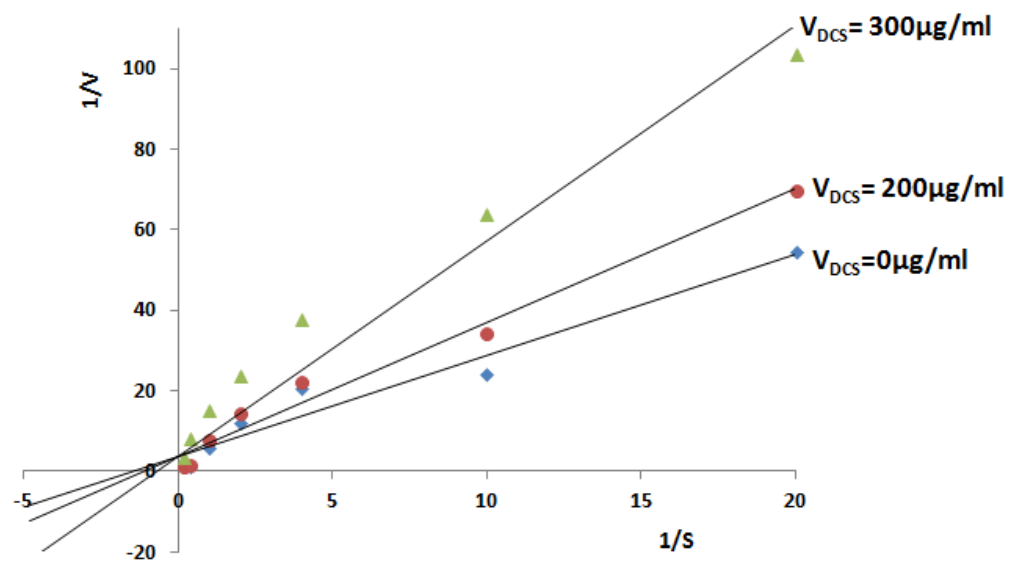
Figure 5. Steady state inhibition by DCS on D -alanyl- D -alanine ligase activity of DdlA. The double-reciprocal plots were obtained without or with different concentrations of DCS. The Lineweaver-Burk plot analysis of the data also confirmed the competitive inhibition.